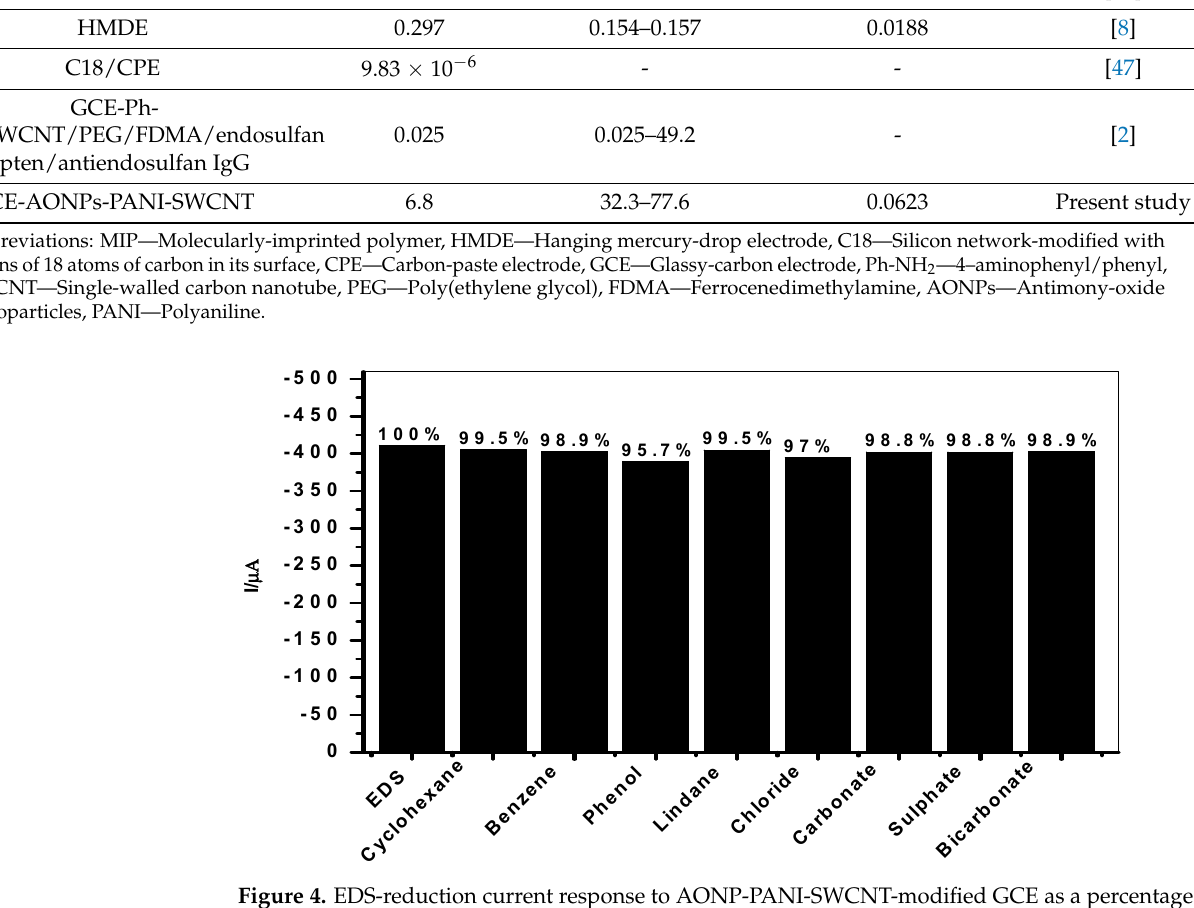
Figure 4. EDS-reduction current response to AONP-PANI-SWCNT-modified GCE as a percentage in the presence and absence of the selected interfering species by CV experiment.